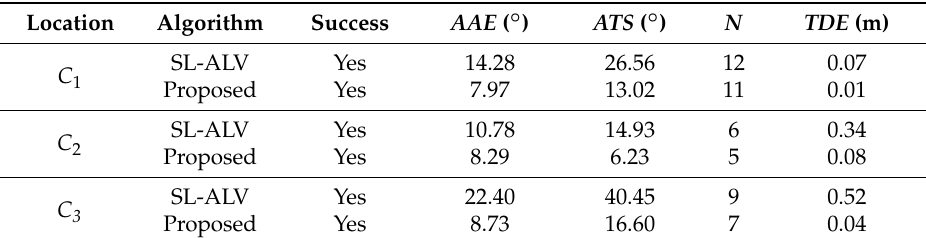
Table 6. Associated results of homing experiment